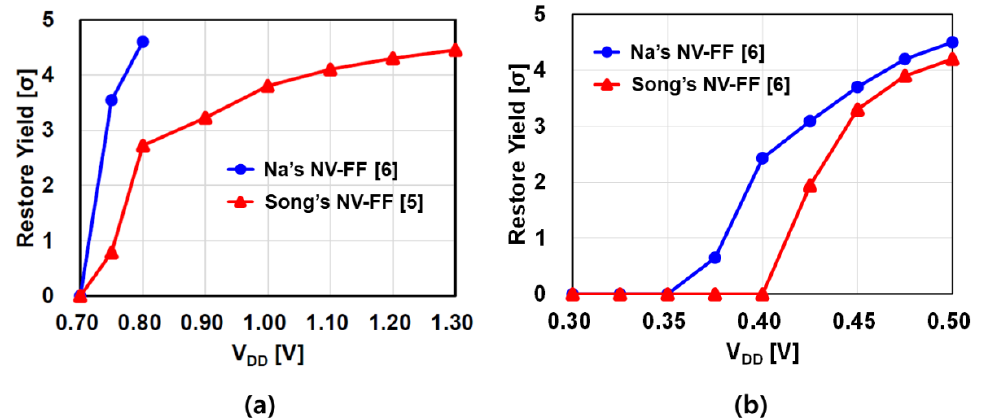
Figure 2. Simulated restore yield of the state-of-the-art NV-FFs according to V DD . (a) Typical V th devices are used for PT, NL, NR, and NB. For all the other transistors, low-V th devices are used. In this simulation, MTJ A = 3 kΩ, MTJ B = 6 kΩ, each phase time = 20 ns, C SA = 20 fF, C CP = 10 fF, W PT = 2 μm, W NB = W NL = W NR = W NL2 = W NR2 = 1 μm, W switch = 0.21 μm, and the minimum length = 0.06 μm for all the transistors. (b) Extremely large devices (10 times larger than the condition in Figure 2a) and low-V th devices are used for all the transistors. In this simulation, MTJ A = 3 kΩ, MTJ B = 6 kΩ, each phase time = 200 ns, C SA = 200 fF, C CP = 100 fF, W PT = 20 μm, W NB = W NL = W NR = W NL2 = W NR2 = 10 μm, W switch = 2.1 μm, and the minimum length = 0.06 μm for all the transistors.